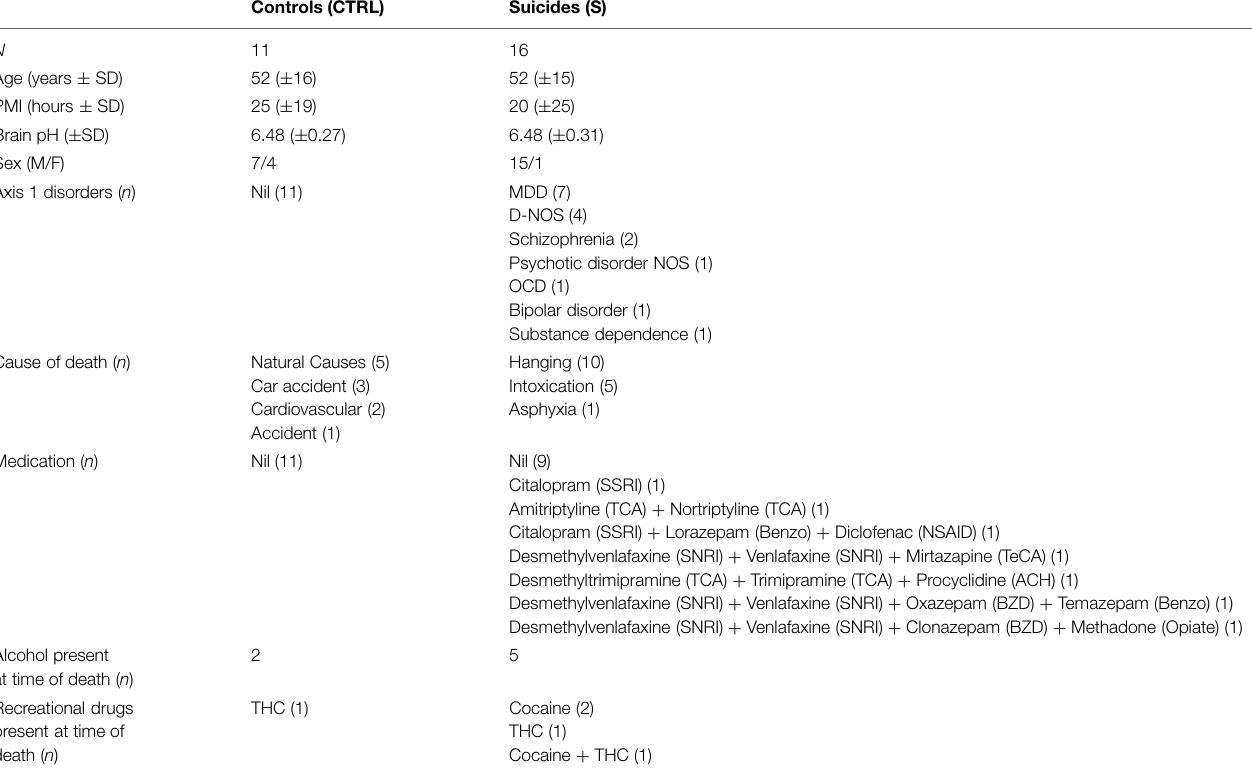
TABLE 1 | Subject